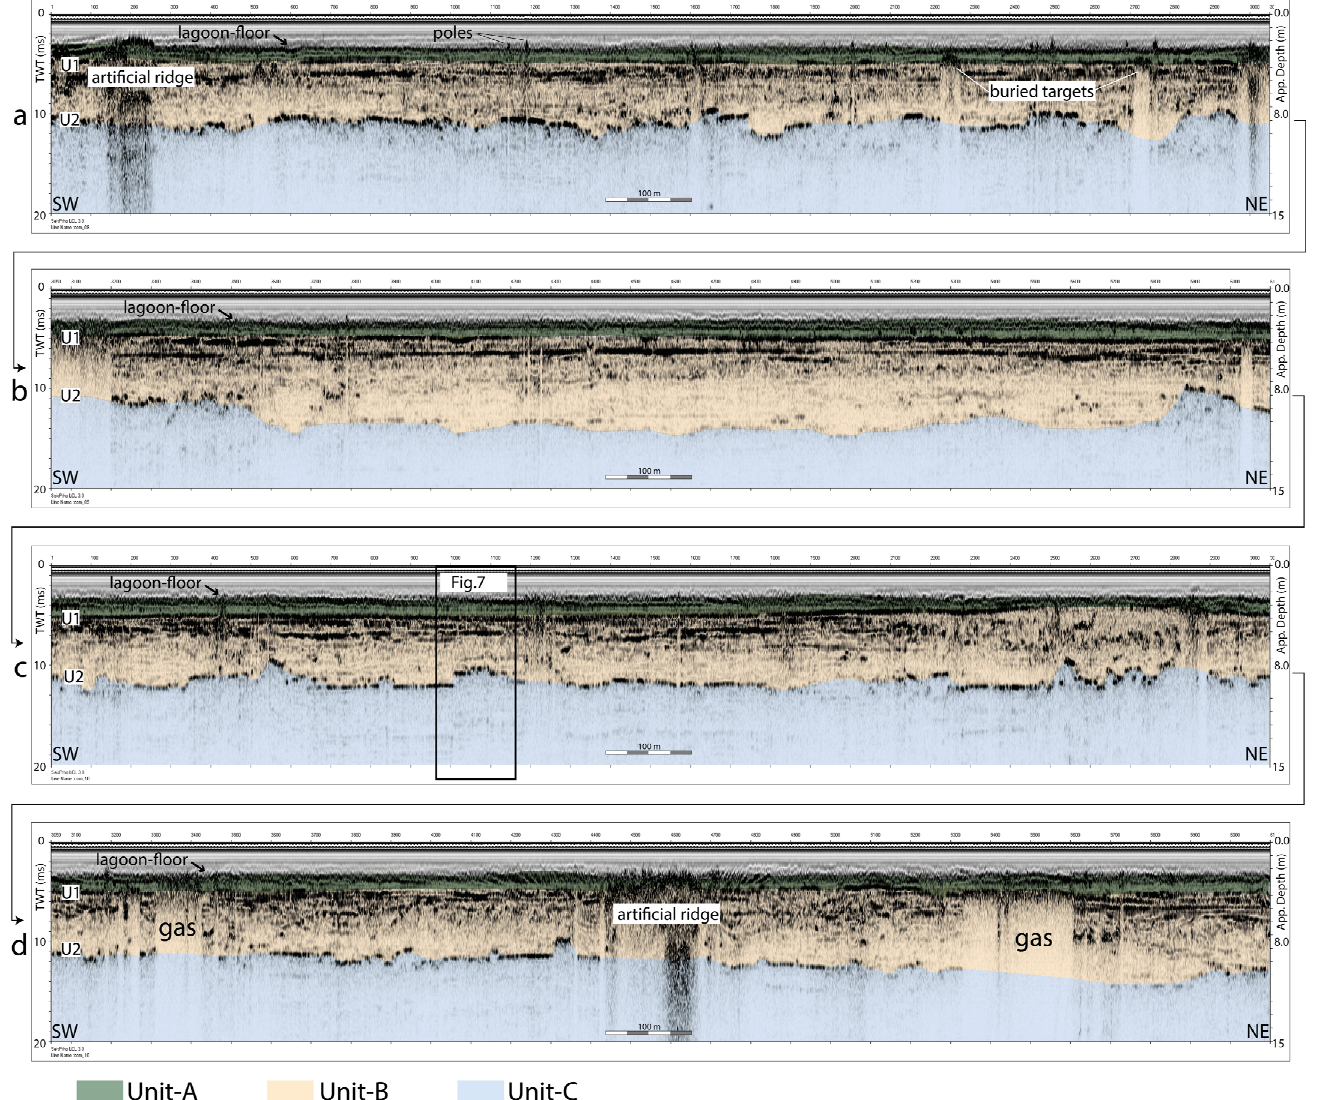
Figure 6. ( a – d ): Seismic reflection profiles showing main seismostratigraphic units and unconformities (U1 and U2). Units-A, -B and -C are indicated as well as major anthropic and natural peculiar reflection patterns (location in Figure 2).